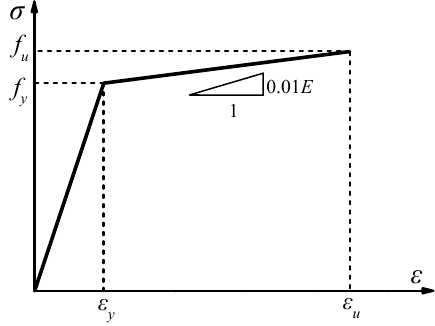
Figure 12. Bilinear stress–strain curve of steel tube.